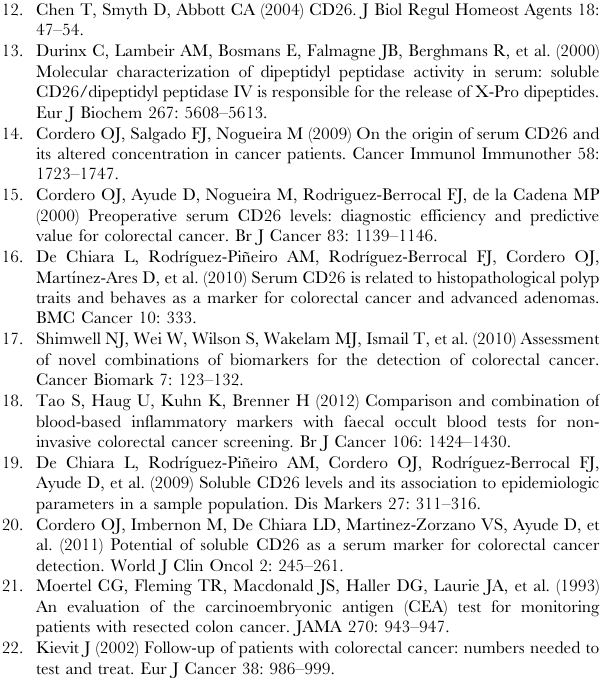
Figure S1 Schematic representation of the behavior of sCD26 during follow-up of CRC patients according to the disease status. Table S1 Clinical characteristics of the cohort followed- up in the study. Table S2 Serum levels of sCD26, CEA, CA-19.9 and CA- 72.4 for preoperative and postoperative